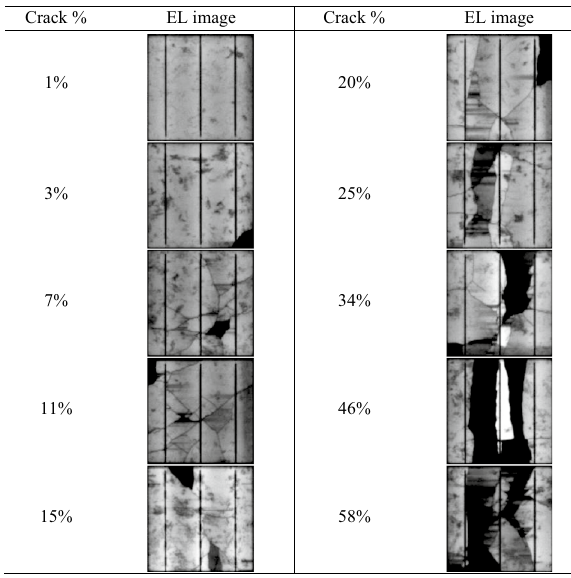
Table 1. Crack size and EL image of the examined solar cell samples.